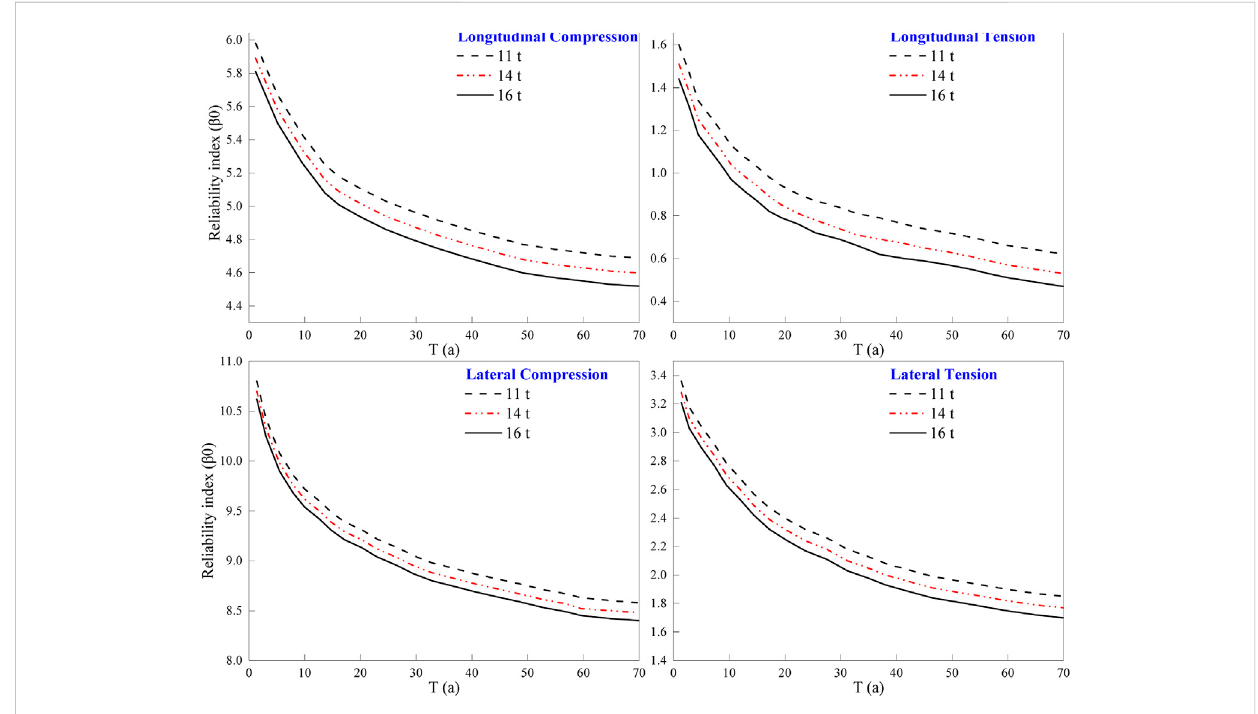
FIGURE 5 Effect of different axle weights on the fatigue reliability of the invert